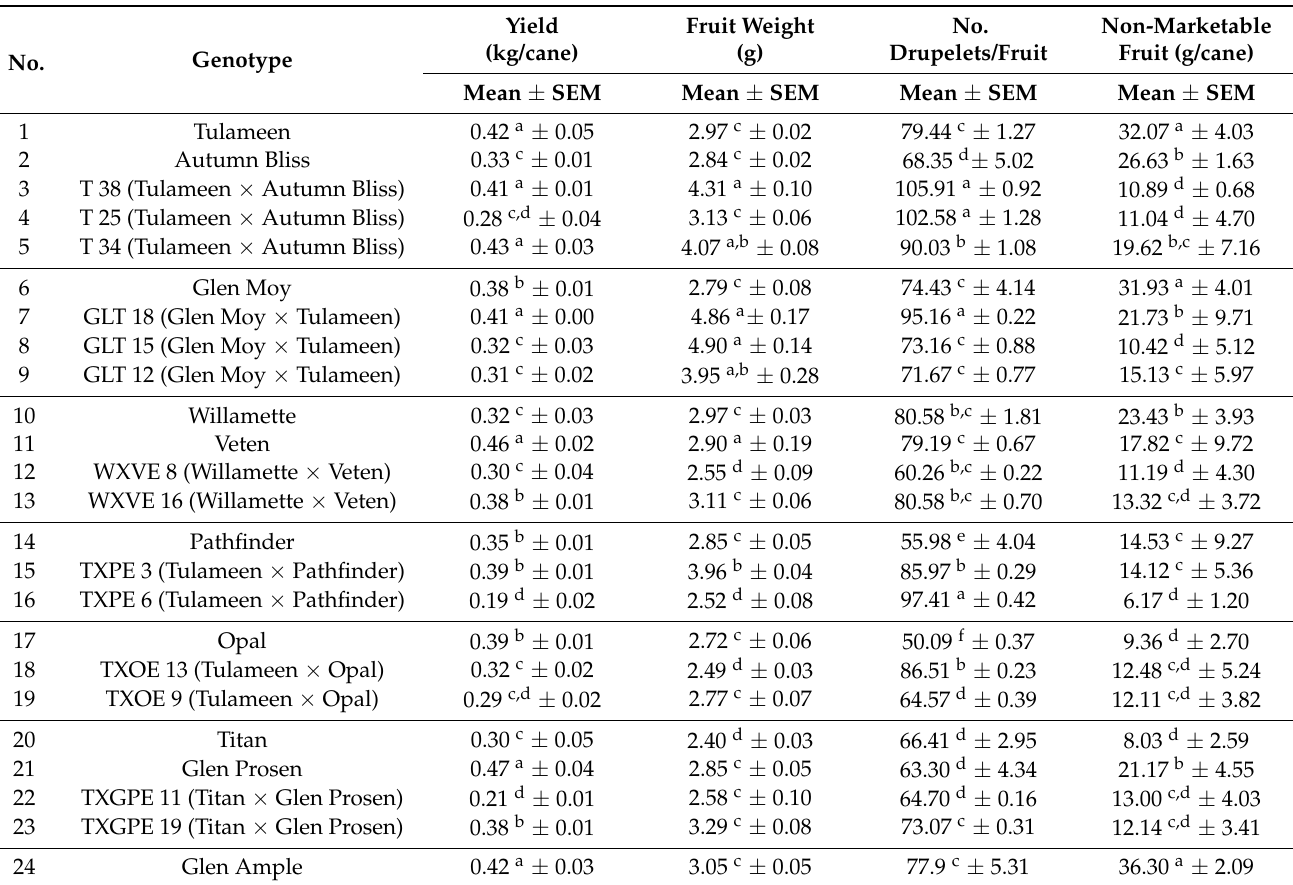
Table 2. The average values for fruit production, fruit weight, number of drupelets per fruit, and non-marketable fruit per cane for 24 raspberry genotypes (14 promising selections (clones), their parents, and Glen Ample cultivar as control).